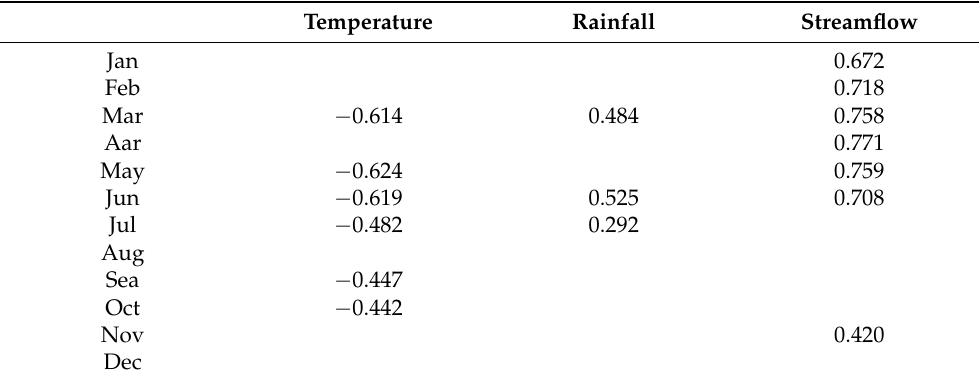
Table 10. Spearman’s test results to identify any correlation between lake’s surface area and hydro- climatic